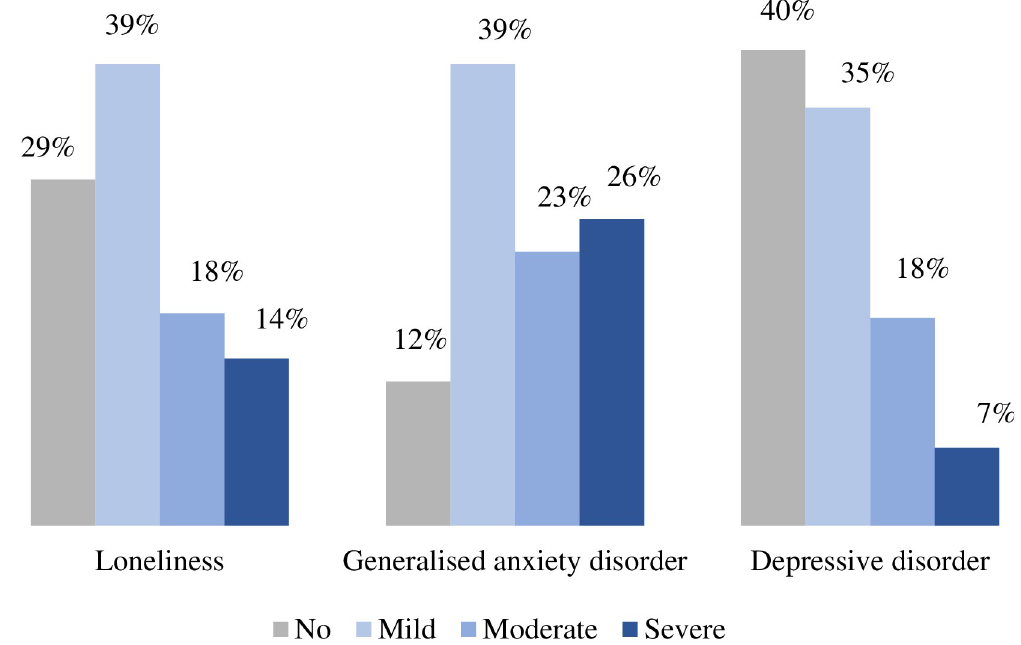
Fig 1. Prevalence and distribution of mental health problems among patients with polycystic ovarian syndrome in Bangladesh. versus unmarried (50.82% vs 49.18%, p = 0.326), (ii) individuals with BMI below 18.5 versus normal (78.26% vs 51.30%, p = 0.003), (iii) individuals with graduation or higher versus pri- mary education background (71.31% vs 0.41%, p = 0.286), (iv) low versus high economic back- ground (57.79% versus 15.57%, p = 0.419), (v) residing in urban versus rural area (78.69% vs 21.31%, p = 0.864), (vi) staying with versus without family (89.34% versus 10.66%, p = 0.248), (vii) non-smoker versus smoker (95.08% vs 4.92%, p = 0.348). At the same time, we estimated the prevalence of loneliness, generalized anxiety disorder, and depressive disorder associated with lifestyle-related factors (Table 2). The high prevalence of loneliness was observed in individuals (i) doing physical exercise irregularly versus regularly (76.47% vs 23.53%, p = 0.554), (ii) taking junk food once a week versus once in a month (36.68% vs 8.99%, p = 0.157), (iii) skipping regular meals versus not skipping regular meals (59.52% vs 40.48%, p = 0.948), (iv) taking meal not timely versus timely (57.44% vs 42.56%, p = 0.032), (v) consuming 8 glasses versus more than 8 glasses of water per day (42.91% vs 17.99%, p = 0.065), (iv) not taking versus taking oral contraceptive pills (85.12% vs 14.88%, p = 0.073). The frequency of having generalized anxiety disorder were higher in (i) doing phys- ical exercise irregularly versus regularly (76.32% vs 23.68%, p = 0.225), (ii) doing exercise for less than 3 days versus at least 3 days (77.72% vs 22.28%, p = 0.095), (iii) skipping regular meals versus not skipping regular meals (59.89% vs 40.11%, p = 0.600), (iv) taking meal not timely versus timely (55.43% vs 44.57%, p = 0.129), (v) not following verses following any birth control method (74.93% vs 25.07%, p = 0.085), (vi) not taking versus taking oral contraceptive pills (85.52% vs 14.48%, p = 0.014). Similarly, respondents were more prone to have depressive disorder in individuals (i) doing physical exercise regularly for less than 30 minutes versus at least 30 minutes (82.38% versus 17.62%, p = 0.009), (ii) taking junk food occasionally versus once in a week (29.92% vs 28.69%, p = 0.005), (iii) skipping regular meals versus not skipping regular meals (65.98% vs 34.02%, p = 0.001), (iv) taking meal not timely versus timely (59.02%